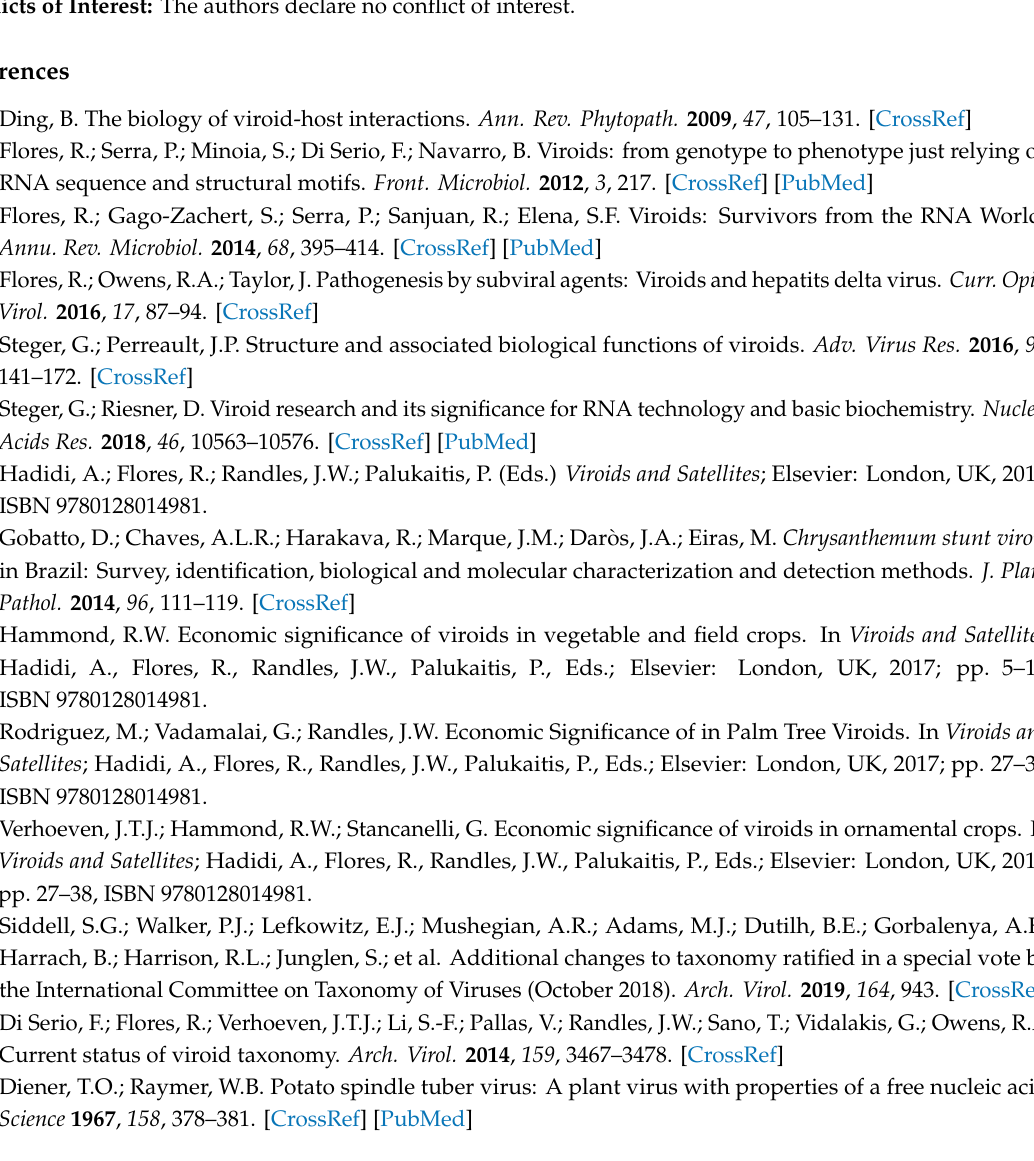
Figure S1: RT-PCR analysis to confirm the infectivity of the Brazilian chrysanthemum stunt viroid (CSVd) isolate in several inoculated hosts. Figure S2. Sequential electrophoresis results on native and denaturing polyacrylamide gels (sPAGE) from the RNA samples extracted from the chrysanthemum plants collected in regions of Artur Nogueira, State of Sao Paulo, Brazil. Figure S3. Sequential electrophoresis results on native and denaturing polyacrylamide gels (sPAGE) from the RNA samples extracted from the chrysanthemum plants collected in regions of Artur Nogueira and Paranapanema, State of Sao Paulo,